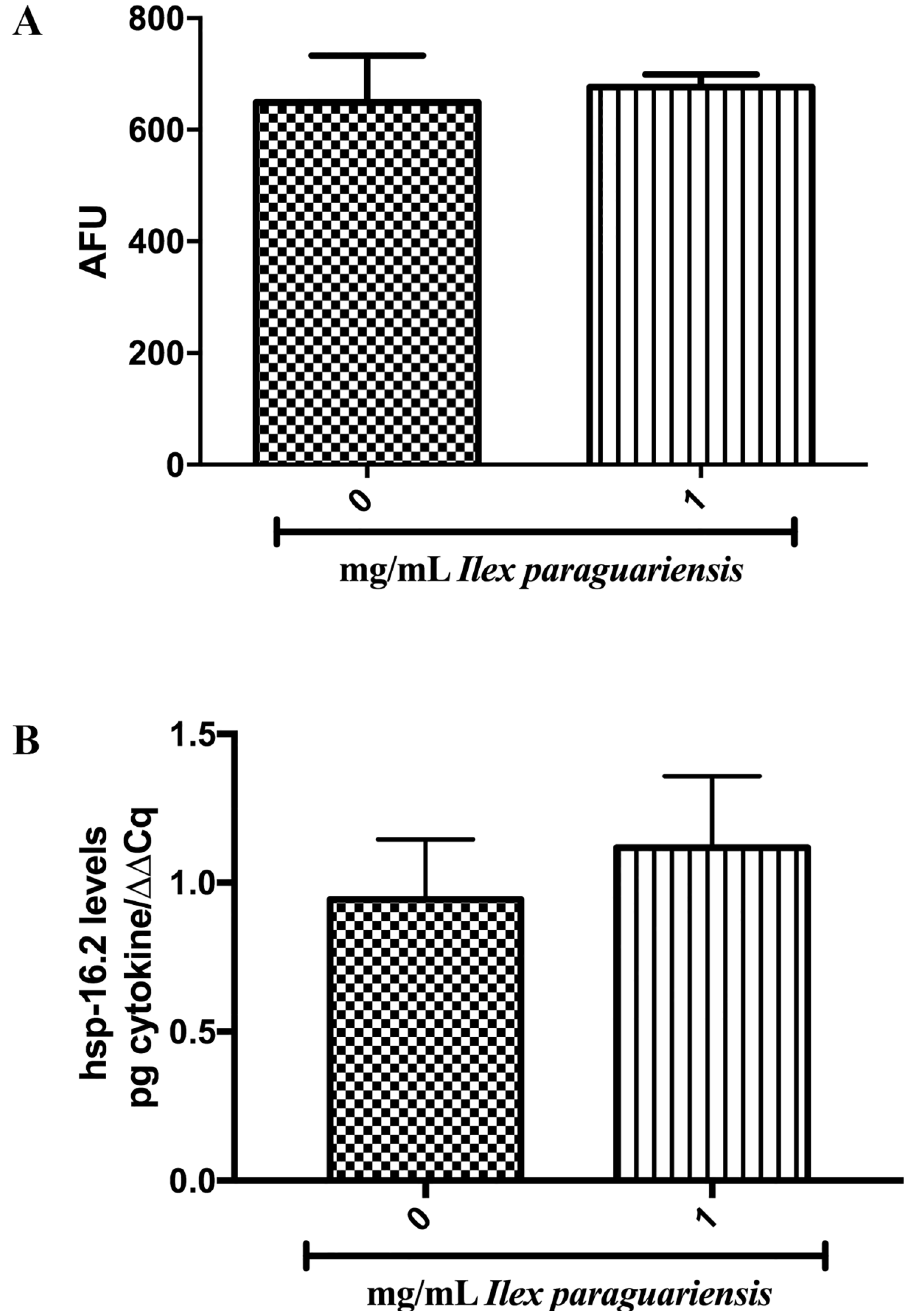
Fig 6. I . paraguariensis on hsp-16 . 2p ::GFP and hsp-16 . 2 transgene expression. (A) Fluorescence expression of hsp- 16 . 2p ::GFP worms. Data are expressed as arbitrary fluorescence units (AFU). (B) hsp-16 . 2 mRNA levels using a ΔΔ Cq method in wild-type (N2). Student’s t -test, p < 0.05. The experiments were performed five times on different days. triplicate with a non-template control also included. SYBR Green fluorescence (Molecular probes) was analyzed by StepOne Plus Software version 2.0 (Applied Biosystems) and Cq value ( Δ Cq) for each sample was calculated and reported using the ΔΔ Cq method [41]. Briefly, for each well, a Δ Cq value was obtained by the difference in Cq values ( Δ Cq) between the target